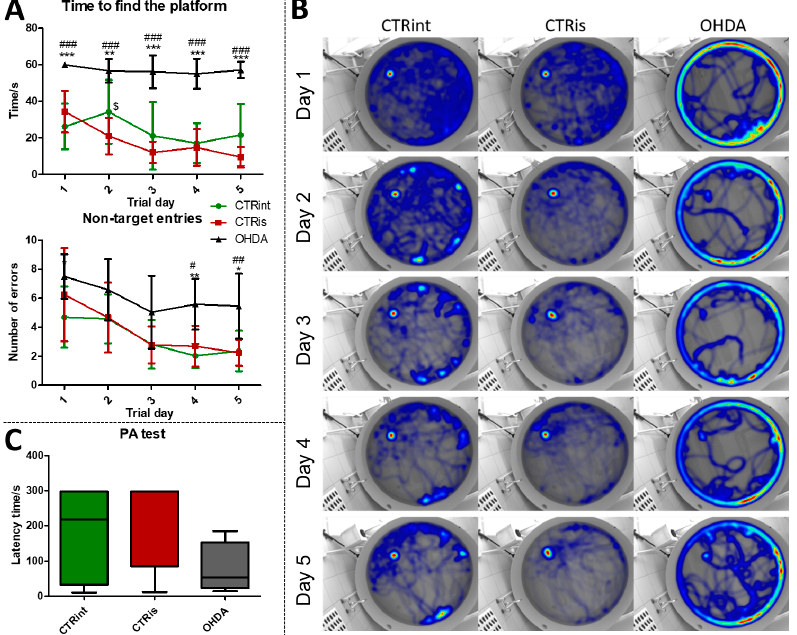
Figure 1. The 6-OHDA induces learning and memory deficit. Learning and memory functions were tested with the Morris maze swimming test (MWM) and Passive Avoidance test (PA) 3 months after intrastriatal administration of 6-OHDA (OHDA). ( A ) Each dot represents a mean value ± SD of the time spent in search for the platform or number of entries into quadrants without platform (non-target entries) during 5 consecutive days. Group comparisons were analyzed by two-way ANOVA for repeated-measures with Bonferroni post-hoc test. ( B ) Merged heatmaps of groups of animals in MWM during 5 consecutive trial days. The color of a pixel represents the total time an animal was at a certain location and the heatmap is based on the all animals’ locations. ( C ) Results (latency time) of the fear-conditioned learning PA test are represented as a box and whiskers (min to max) plot with between-group differences tested by two-tailed Kruskal–Wallis one-way analysis of variance, followed by the Mann–Whitney U-test, with p < 0.05 considered statistically significant (* p < 0.05, ** p < 0.01, *** p < 0.001 vs. CTRint; # p < 0.05, ## p < 0.01, ### p < 0.001 vs. CTRis; $ p <